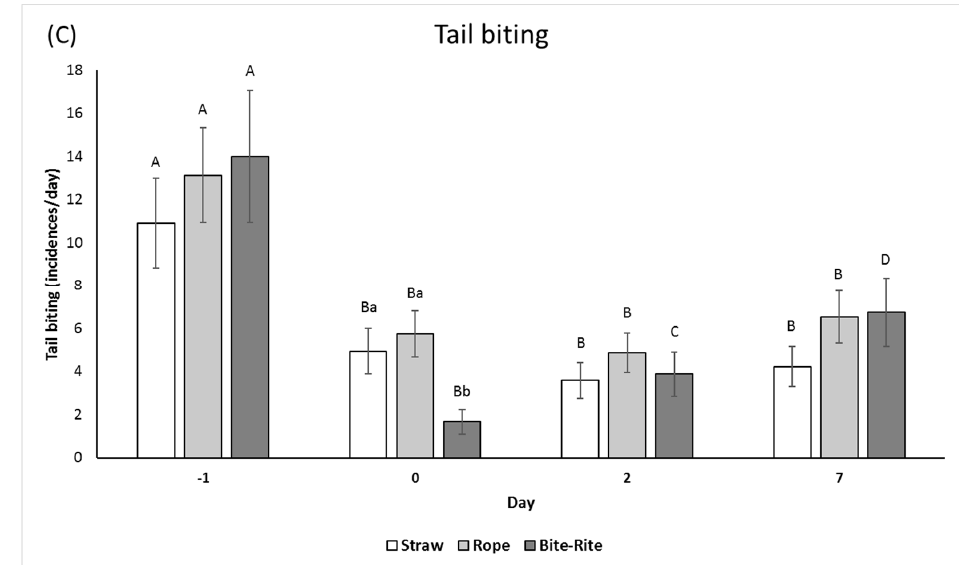
Figure 3. Tail interest ( a ), tail-in-mouth ( b ), and tail biting ( c ) presented as frequency per day (LSmean ± SE) for each enrichment treatment (straw, rope and Bite-Rite) on day − 1, 0, 2, and 7 (80 min observation period per day). Different lowercase letters indicate a significant difference of p < 0.05 between treatments within days. Different uppercase letters indicate a significant difference of p < 0.05 between days within treatments.